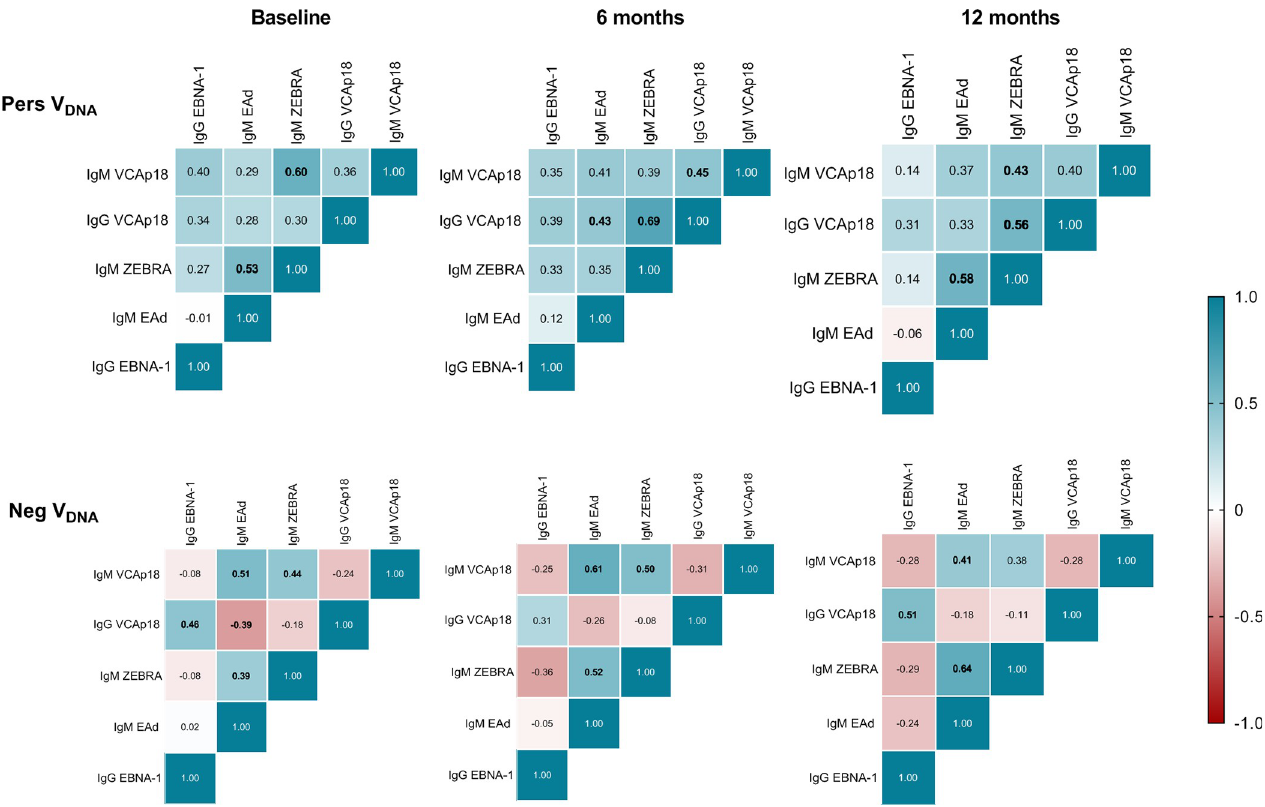
Fig 2. Pairwise correlations between EBV antibody levels in individuals whose EBV-DNA could be detected (PersV DNA ) or not (NegV DNA ) over the follow-up period. Clustering was based on the Spearman correlation coefficient for assays measuring anti-EBV antibodies in plasma samples [IgM (VCA-p18, Zebra and EAd-p45/52) and IgG (VCA-p18 and EBNA-1)]. Matrix heatmaps were shown for each cross-sectional survey (baseline, 6- and 12-months), with top and bottom panels representing PersV DNA and NegV DNA groups, respectively. Positive correlations shown in blue and negative correlations shown in red, with numbers in bold statistically significant